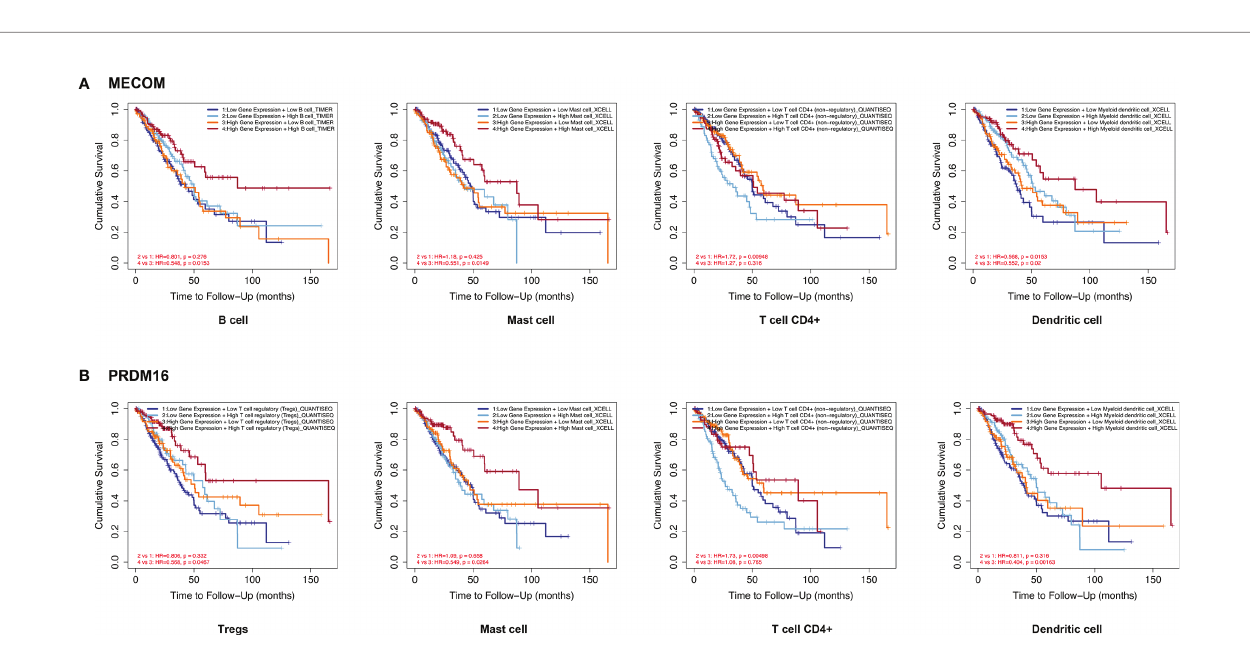
FIGURE 6 | Correlation between MECOM (A) , PRDM16 (B) expression, and the level of immune cell in fi ltration in LUAD. MECOM, MDS1 and EVI1 complex locus, also called PRDM3; PRDM16, PR domain containing 16, also called MEL1; LUAD, lung adenocarcinoma.